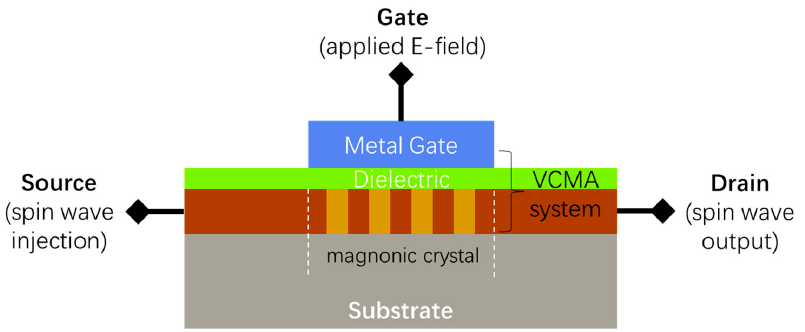
Figure 6. Schematic illustration of a spin-wave transistor proposal based on a VCMA-controlled spin-wave filter using width-modulated magnonic crystals. The VCMA system composed of a metal gate layer, a dielectric layer, and a magnonic-crystal layer was adapted to allow (binary code 1) or forbid (binary code 0) the propagation of spin-wave signals.